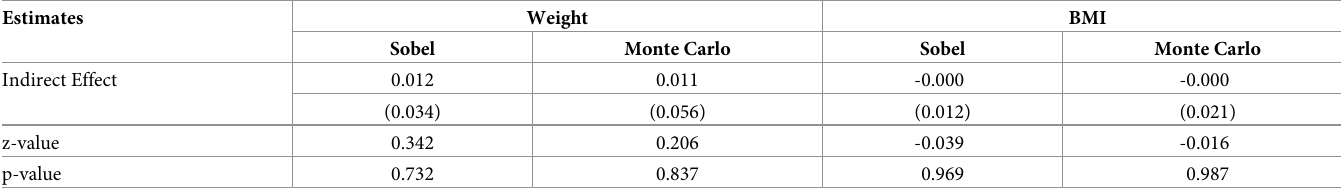
Table 4. Significance testing of indirect effect on biometric